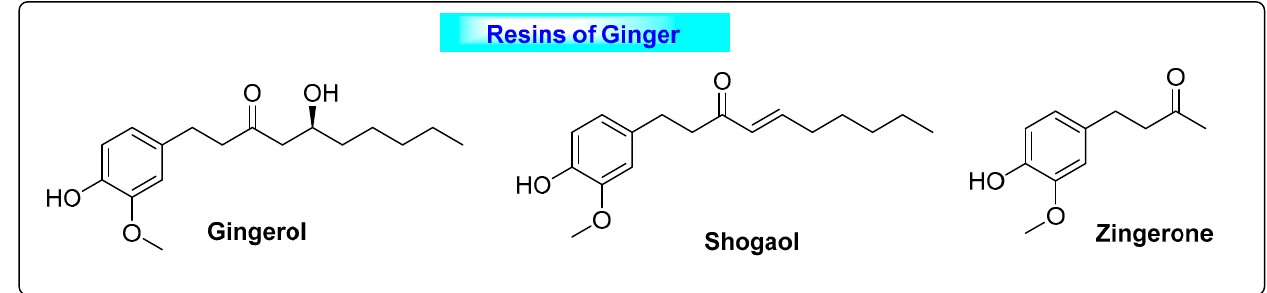
Figure 18. Resinous substances of Zingiber officinalis .